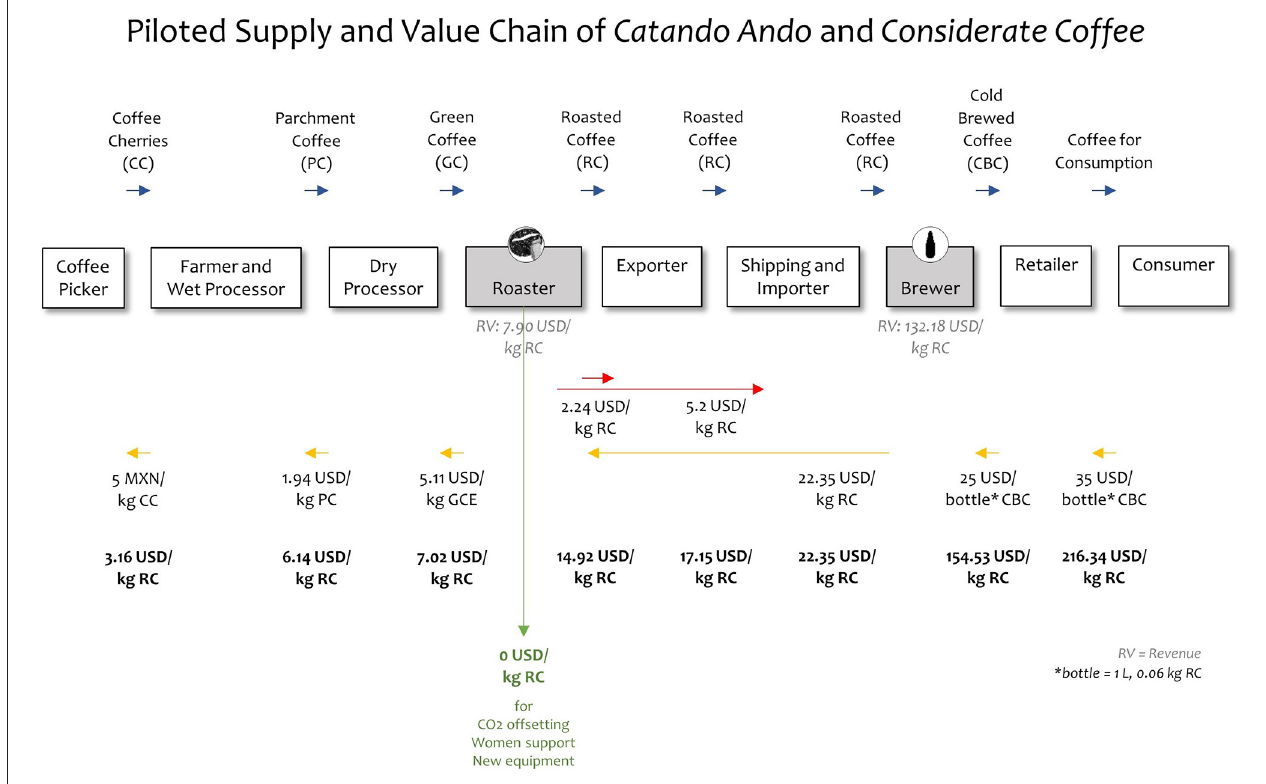
FIGURE 4 | Piloted coffee supply and value chain of Considerate Coffee and Catando